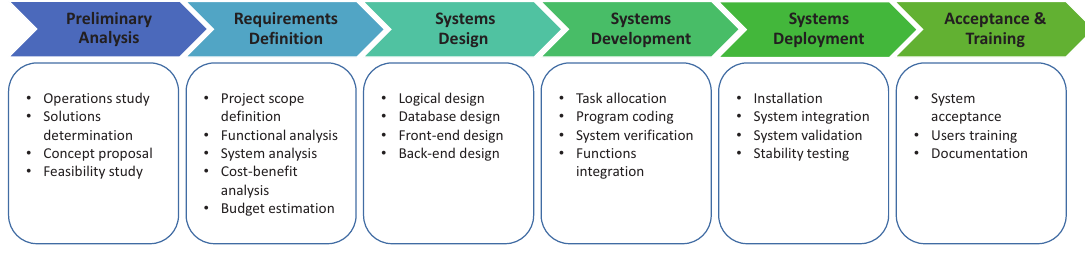
Figure 11. The working procedure of this WPH